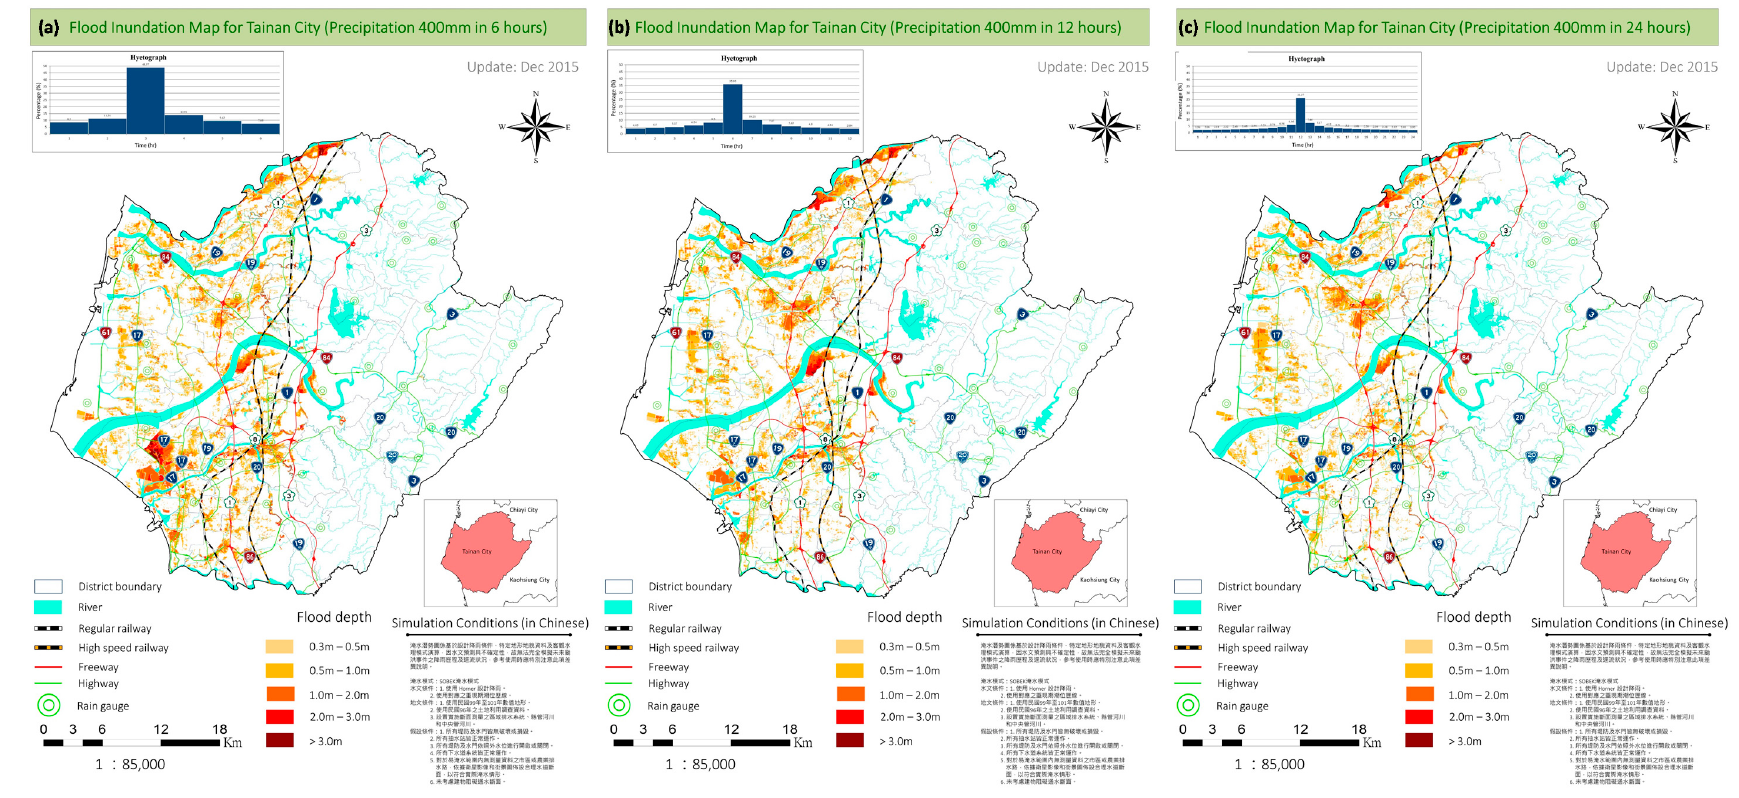
Figure 12. Productions of flood inundation map for Tainan City under conditions: ( a ) cumulative rainfall 400 mm for 6 h (CR ‐ 6 ‐ 400); ( b ) cumulative rainfall 400 mm for 12 h (CR ‐ 12 ‐ 400); and ( c ) cumulative rainfall 400 mm for 24 h (CR ‐ 24 ‐ 400).